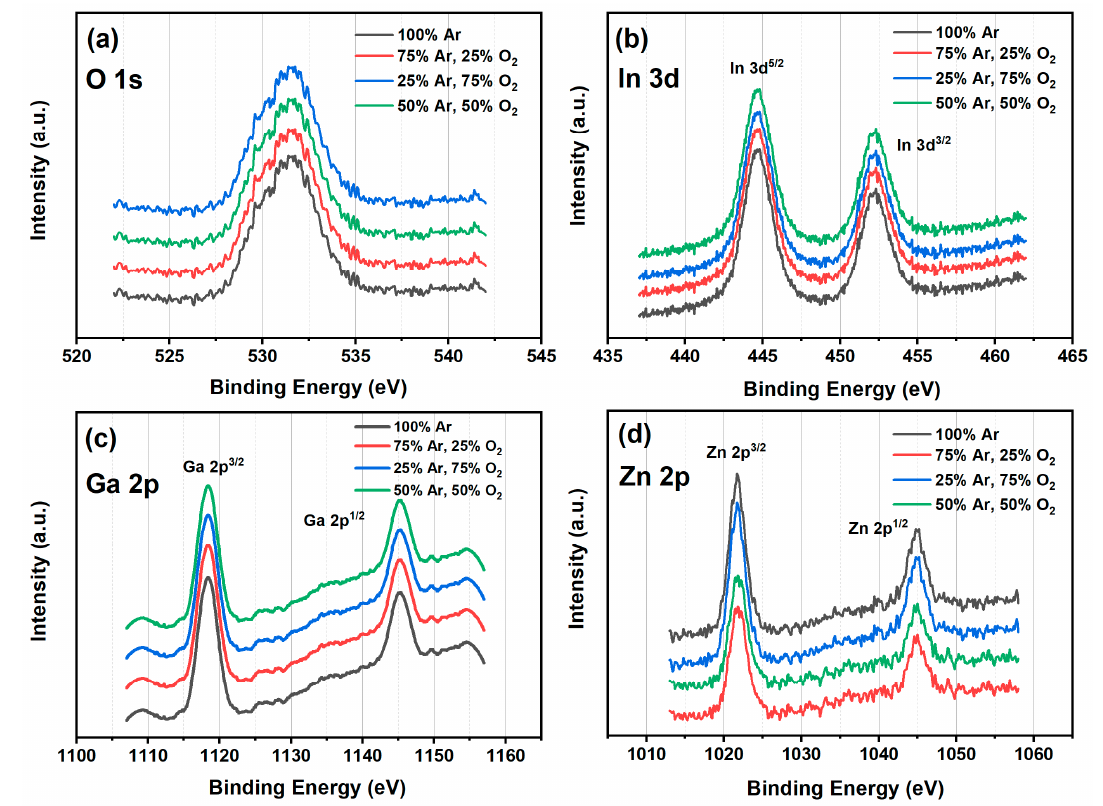
Figure 4. The XPS spectrum of the IGZO at different deposition atmospheres. ( a ) O 1s; ( b ) In 3d; ( c ) Ga 2p; ( d ) Zn 2p.